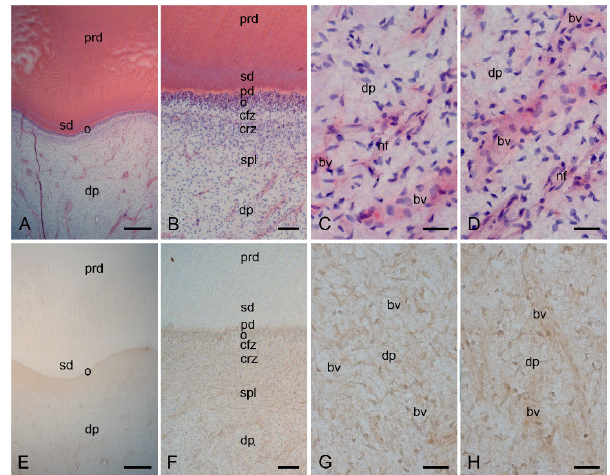
Figure 1. Histopathological characterization of healthy human dentin–pulp complex via hematoxylin and eosin (HE) staining and the expression of mast cell tryptase (MCT) in cells from consecutive sections of healthy human dental pulp. The structural order of the healthy dentin–pulp complex in the overview image ( A ) is visible in the detailed images as primary dentin (prd), secondary dentin (srd), predentin (pd), odontoblast layer (o), cell-free zone (cfz), and cell-rich zone (crz) ( B ), and blood vessels (bv), nerve fibers, and numerous pulp cells in the human dental pulp (dp) ( C,D ). In the cells of the healthy dental pulp of the consecutive section, the immunohistochemical localization for MCT is not visible in the overview ( E ) and detailed images ( F – H ). Scale bars: ( A , E ) = 500 µm; ( B , F ) = 100 µm; ( C , D , G , H ) = 30 µm.